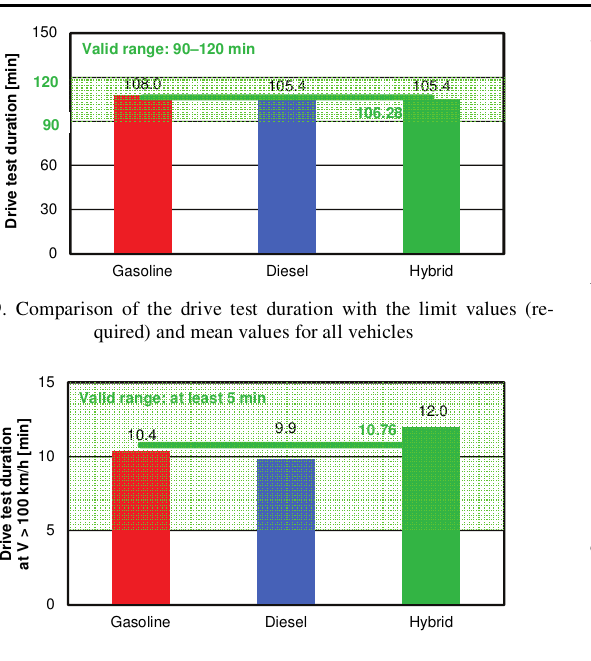
Fig. 10. Comparison of the drive duration with a speed over 100 km/h on the motorway section of the test with the limit value (required) and mean values for all vehicles